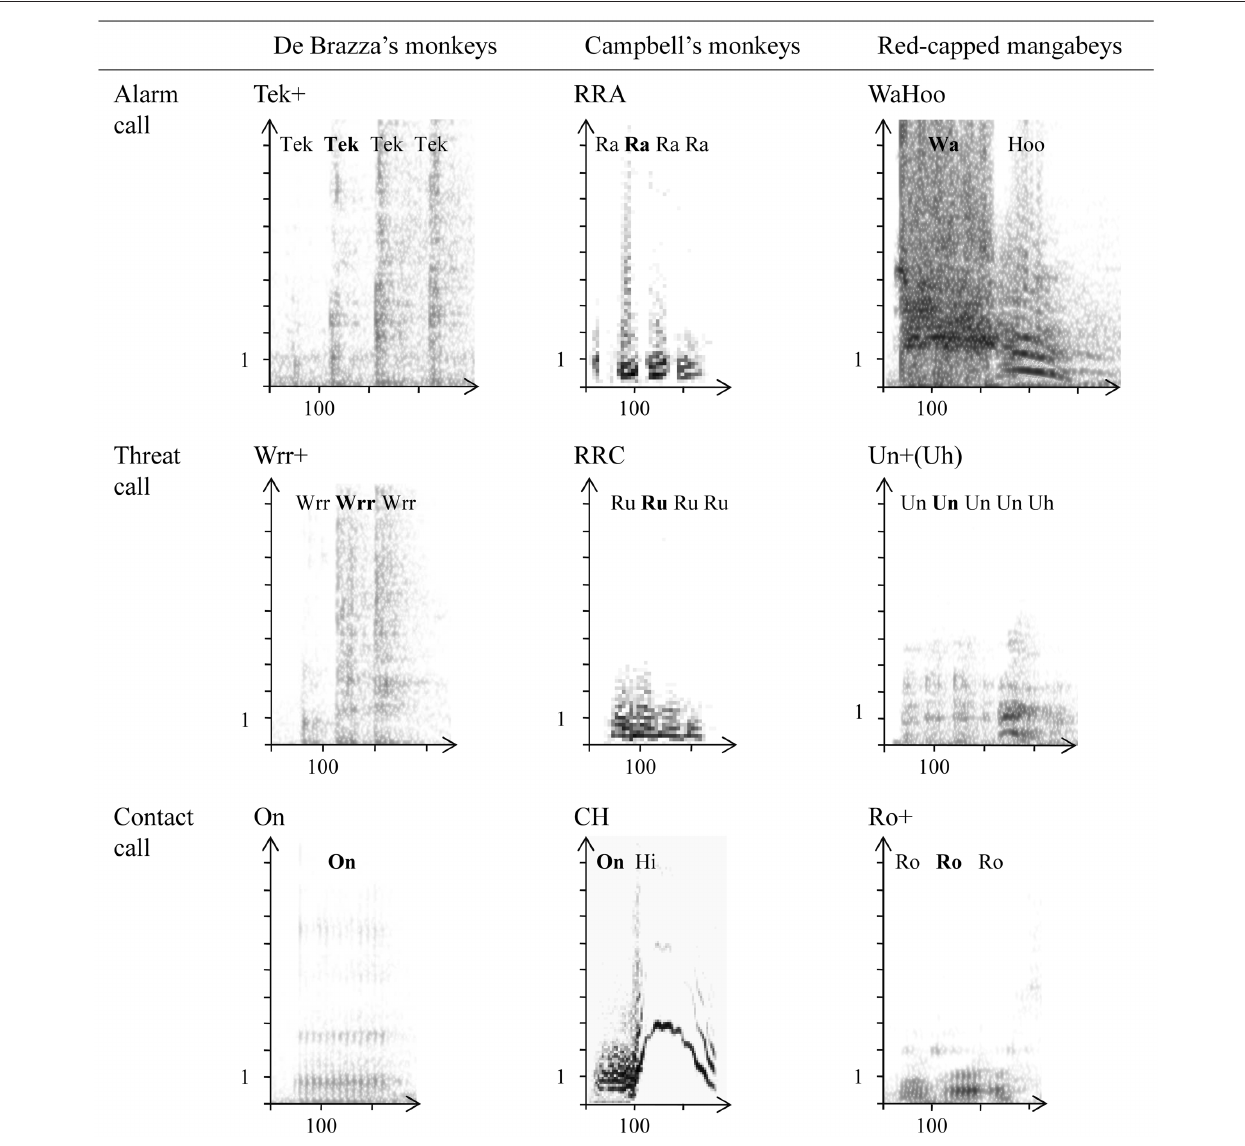
FIGURE 1 | Sonograms of contact, threat and alarm calls in De Brazza’s monkeys, Campbell’s monkeys, and red-capped mangabeys. Sonograms: X-axis: duration (ms), Y-axis: frequency (kHz). The call type name is given above the sonogram call types are labeled as in previous publications (De Brazza’s monkeys: Bouchet et al., 2012b; Campbell’s monkeys: Lemasson and Hausberger, 2011; red-capped mangabeys: Bouchet et al., 2010). Each sonogram is labeled according to the composition in units of the call (units are named using onomatopoeia), and the unit on which measurements have been performed is set in bold type. In the three species, alarm calls display a noisy pattern. In guenons, alarm calls (“Tek + ” and “RRA”) consist of